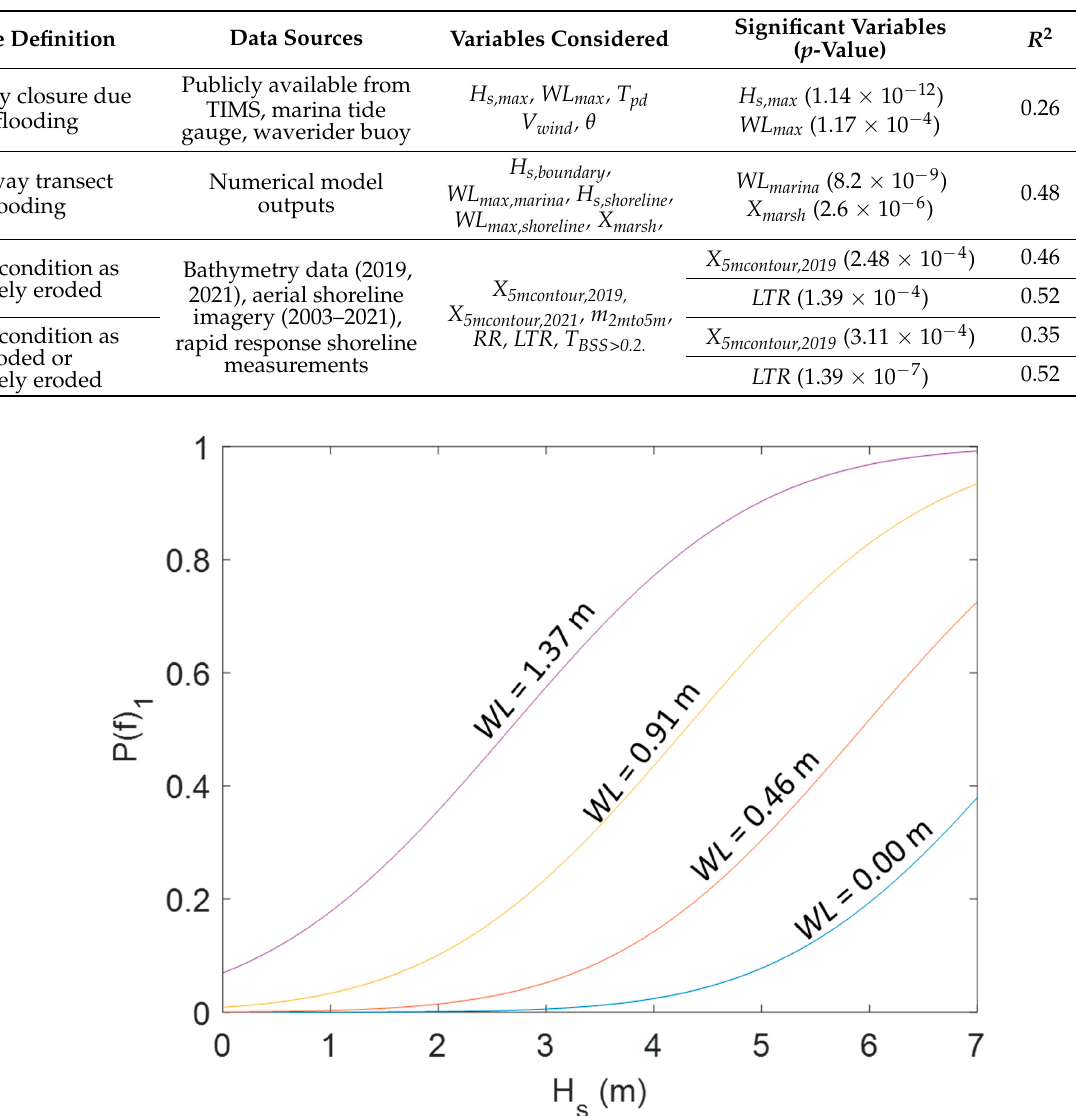
Table 3. Summary of fragility model derivation methods, definition of failure, data sources, variables considered, significant variables based on p < 0.01, and model R 2 values.